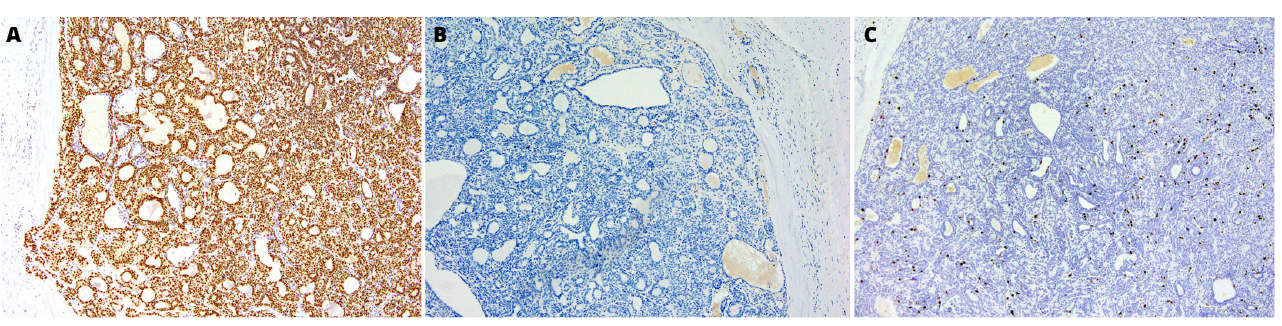
Figure 4. ( A ) Positive immunohistochemical staining for SOX10. ( B ) Negative immunoreactivity for chromogranin. ( C ) The Ki-67 labeling index (LI) in the tumor was about 10%. Obj. magnification 200×.